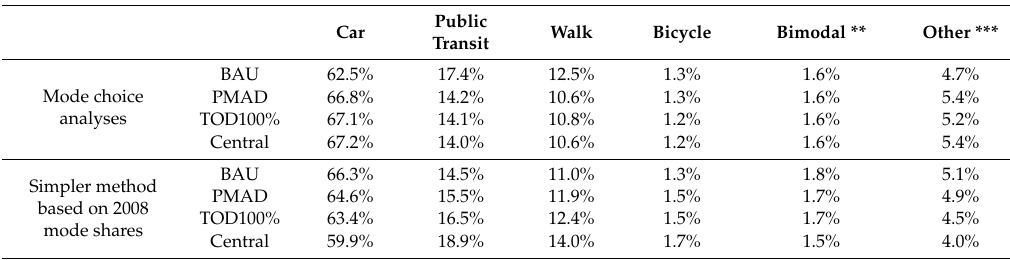
Table A2. Modal share for each 2031 scenario, according to mode choice analyses and to our simpler method (weighted trips)